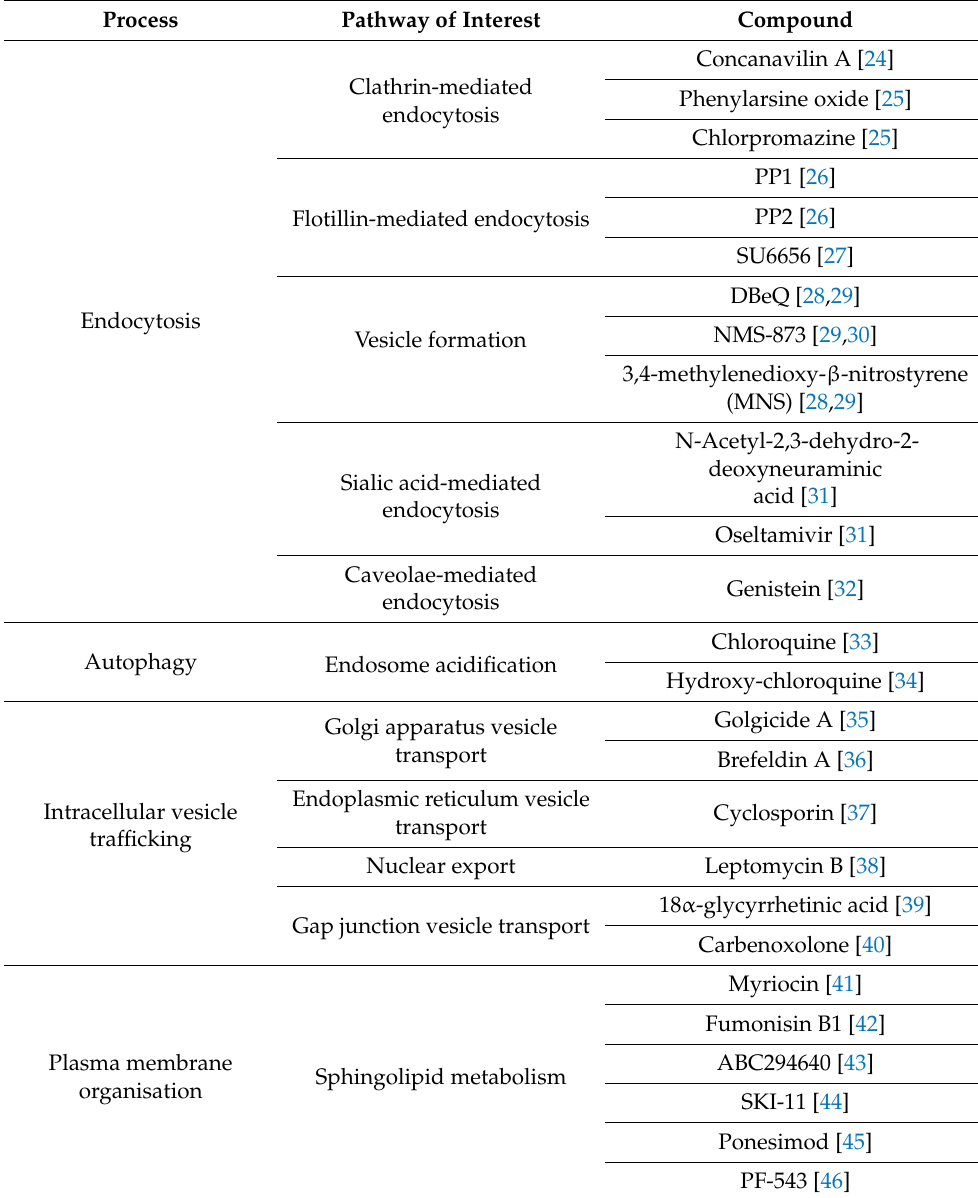
Table 1. Summary of 26 compounds assessed during the initial drug screen. Compounds are separated by process, and the underlying specific biological